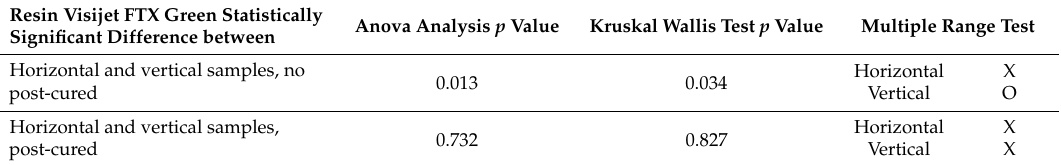
Figure 4. Castable resin in Projet 1200. Different build directions. Table 4. Statistical study for Visijet FTX green in system DLP Projet 1200.